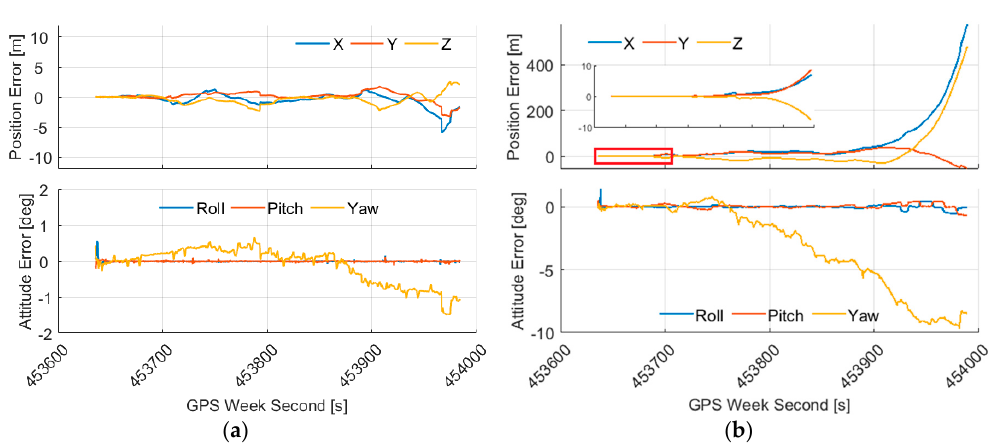
Figure 5. The RMSEs of thePOS620 under 0-degree geodetic displacement for the sequence WRIC: ( a ) The RMSEs for Setting A, and ( b ) the RMSEs for Setting B. The trajectories of the two IMUs for the sequences WRIC and GFH under different settings and two-degree geodetic displacements are plotted in Figure 6.